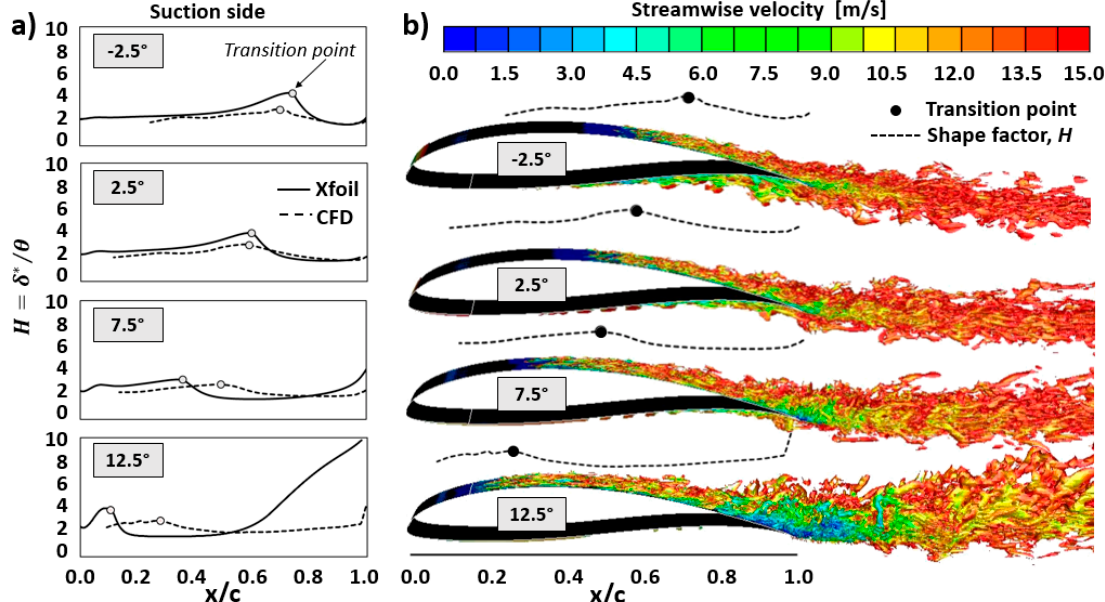
Figure 11. ( a ) Shape factor distribution on the suction side for different angles of attack. ( b ) Isosurfaces of Q-criterium, corresponding to Q = 5 × 10 4 s − 2 and colored by instantaneous streamwise velocity, as a function of the angle of attack.